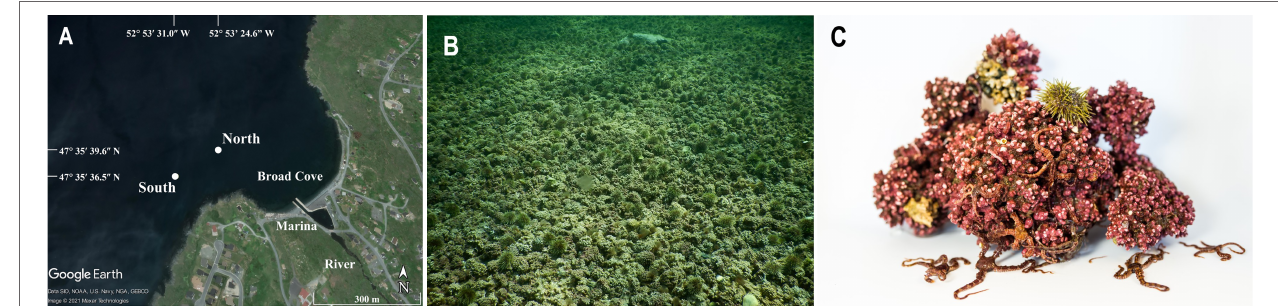
FIGURE 1 | (A) Location of the two study sites within the rhodolith ( Lithothamnion glaciale ) bed fringing St. Philip’s (southeastern Newfoundland) used to study rhodolith bed trophodynamics. The present study focuses on the food web at the “South” site in the spring of 2017. The “North” site is included in a follow up study (Hacker Teper, 2022) examining spatial and temporal variability in food web structure. Both sites are located at the periphery of Broad Cove, which receives seasonally variable volumes of freshwater from the adjacent marina and river to which it is connected (Image: Google Earth). (B) Section of the rhodolith bed at the South site at a depth of ~15 m. Rhodoliths are tightly aggregated, with very little to no epiphytes and a relatively high abundance of green sea urchins ( S. droebachiensis ) moving on the bed surface (the biggest urchins are ~6 cm in test diameter) (Image: Patrick Gagnon). (C) Staged photograph of rhodoliths ( Lithothamnion glaciale ) and associated macrofauna (visible: Ophiopholis aculeata, Strongylocentrotus droebachiensis , cryptic: Tonicella spp.) out of water from a laboratory bench at the Ocean Sciences Centre. (Image: Sean Hacker Teper).